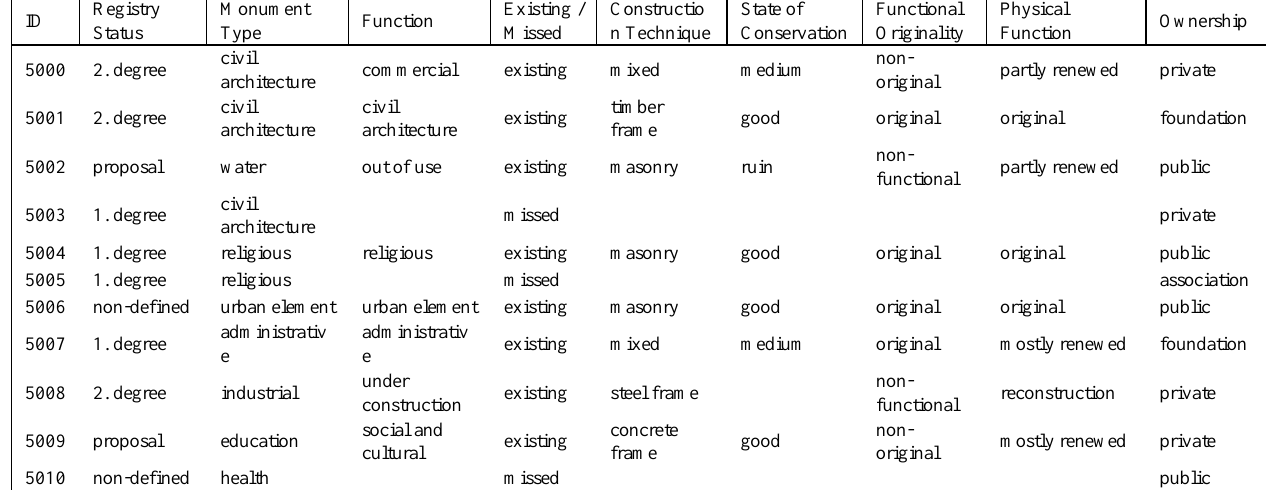
Table 1. Distinct Data Types Used For Spatial